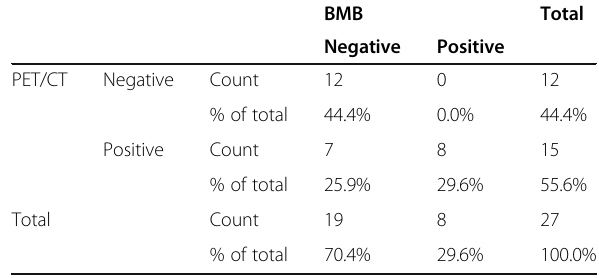
Table 13 Agreement between PET/CT and BMB in DLBCL